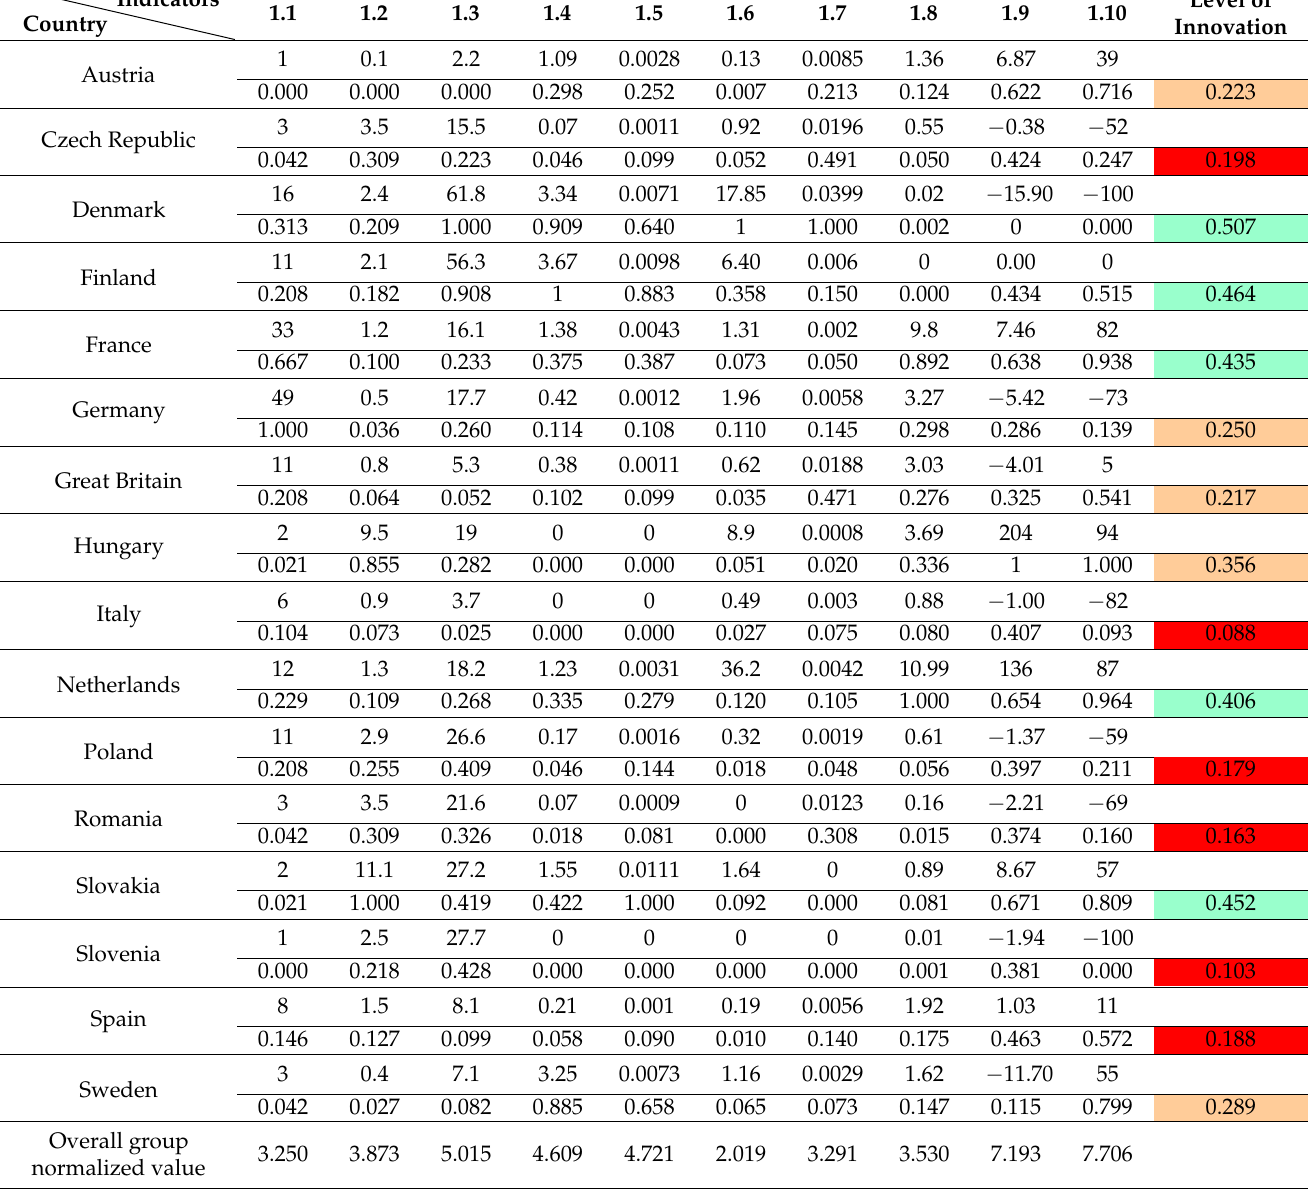
Table 3. Level of innovation in the bioenergy